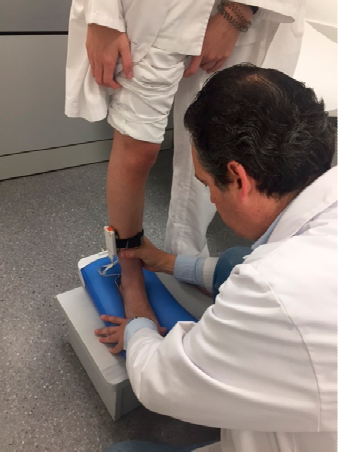
Figure 2. Taking the standing cast with pressure sensors.